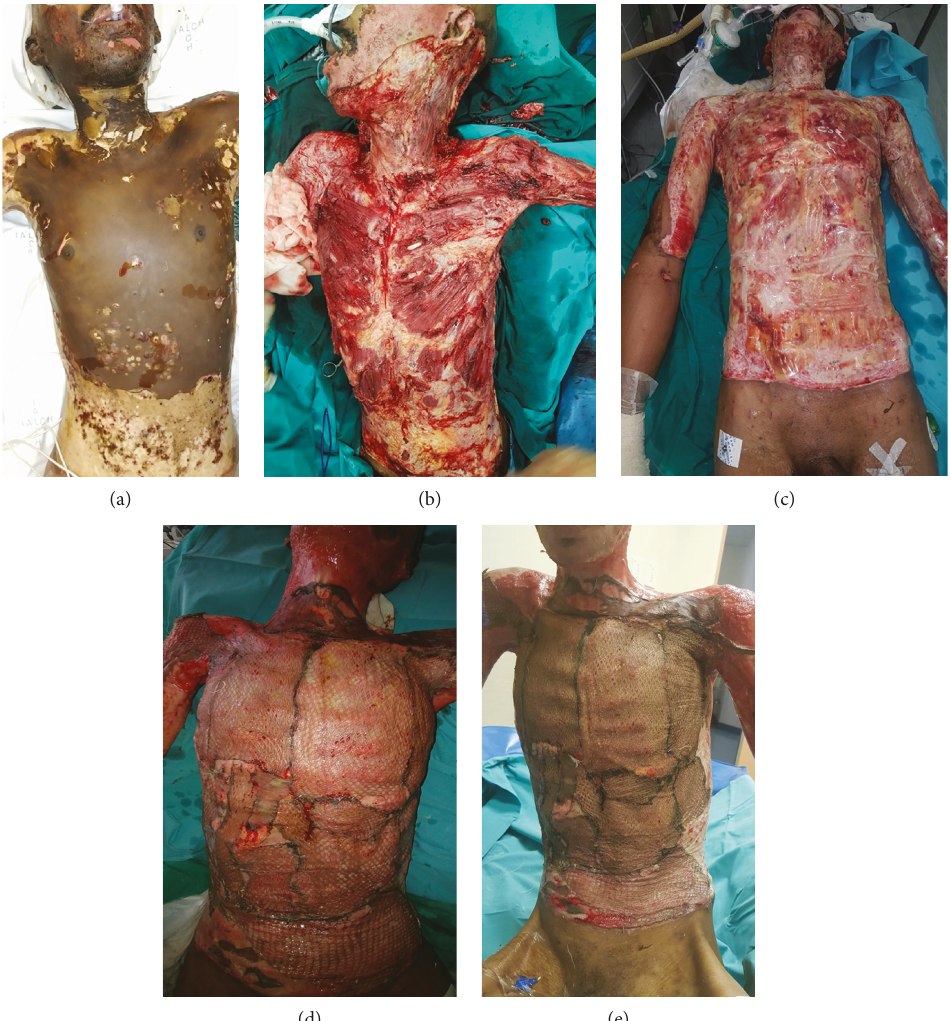
Figure 2: Representative images for patient 1. (a) Admission picture where a full-thickness burn over the anterior torso and neck is evidenced. (b) Post excision of burn eschar. (c) After application of Integra. (d) After application of PRF/spray-on skin; fi rst dressing change: near- complete reepithelialization of grafted areas. (e) Results after 10 days